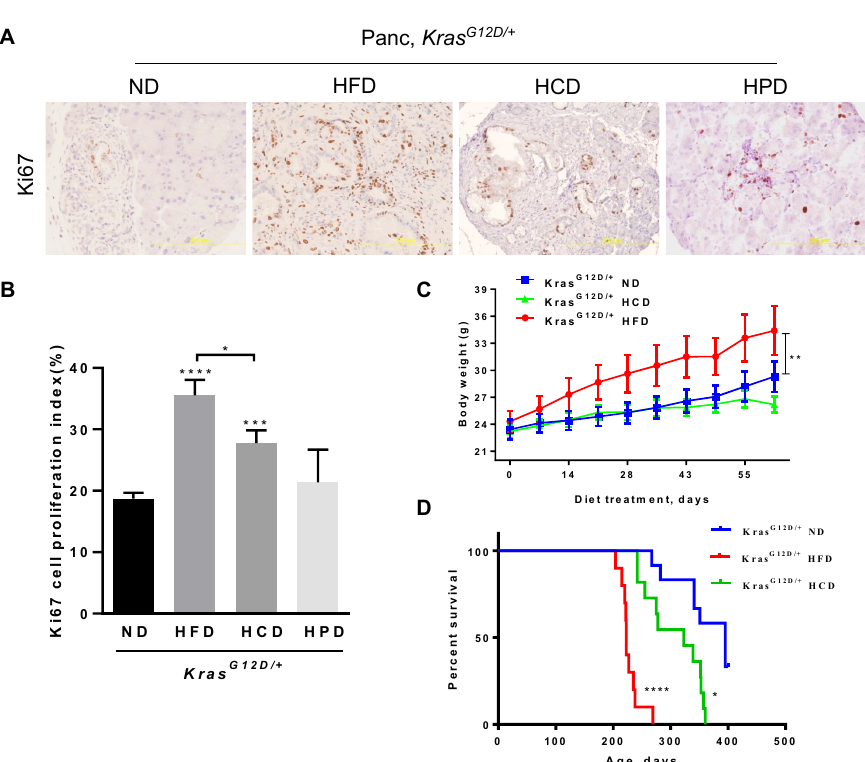
Figure 3. Differential effects of different macronutrient diets on pancreatic cell proliferation, body weights, and survival rates in KRAS G12D/+ mice. ( A ) Ki67 IHC staining was performed to detect pancreatic cell proliferation of Kras G12D/+ mice after 10-week ND, HFD, HCD, or HPD treatment, with hematoxylin counterstaining. Magnification: 200×. ( B ) Quantification of pancreatic cell proliferation by manually counting Ki67-positive nuclei of ductal cells. ( C ) Body weight of Kras G12D/+ mice fed an ND, an HFD, or an HCD. At 75 days old, tamoxifen was administrated to mice by intraperitoneal injection for 5 days to activate Kras G12D/+ expression. ND, HFD or HCD treatment started on day 80 for 10 weeks. Body weight was measured weekly. ( D ) Survival rates of Kras G12D/+ mice treated with HFD (red line), HCD (green line), or ND (blue line). *, **, *** and ****, p -value < 0.05, 0.01, 0.001 and 0.0001, respectively.